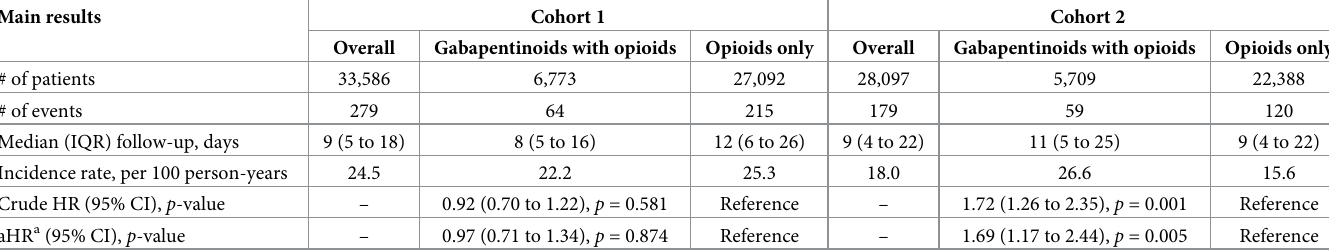
Table 2. Risk of fall-related injury comparing concurrent gabapentinoid–opioid users and opioid-only